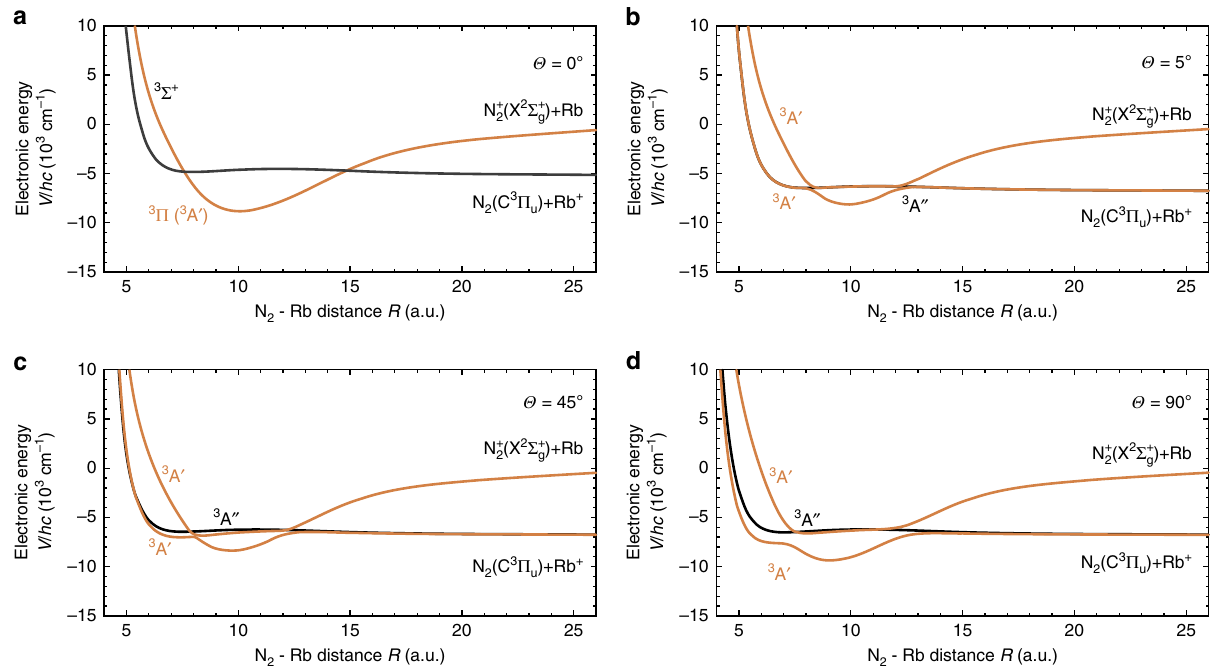
+ Rb. Cuts of the potential energy surface in the triplet channel for charge-transfer (CT) Fig. 6 Non-adiabatic interactions in the triplet channel of N þ 2 reactions of Rb( 2 S 1 = 2 ) with N þ at different orientation angles θ . R denotes the N 2 – Rb separation. CT occurs predominantly through non-adiabatic 2 interactions around the avoided crossing points of the two 3 A 0 surfaces in C s symmetry. Panels a – d show cuts through the coupled surfaces at N 2 – Rb orientation angles θ ¼ 0 ; 5 ; 45 and 90 (cid:6)